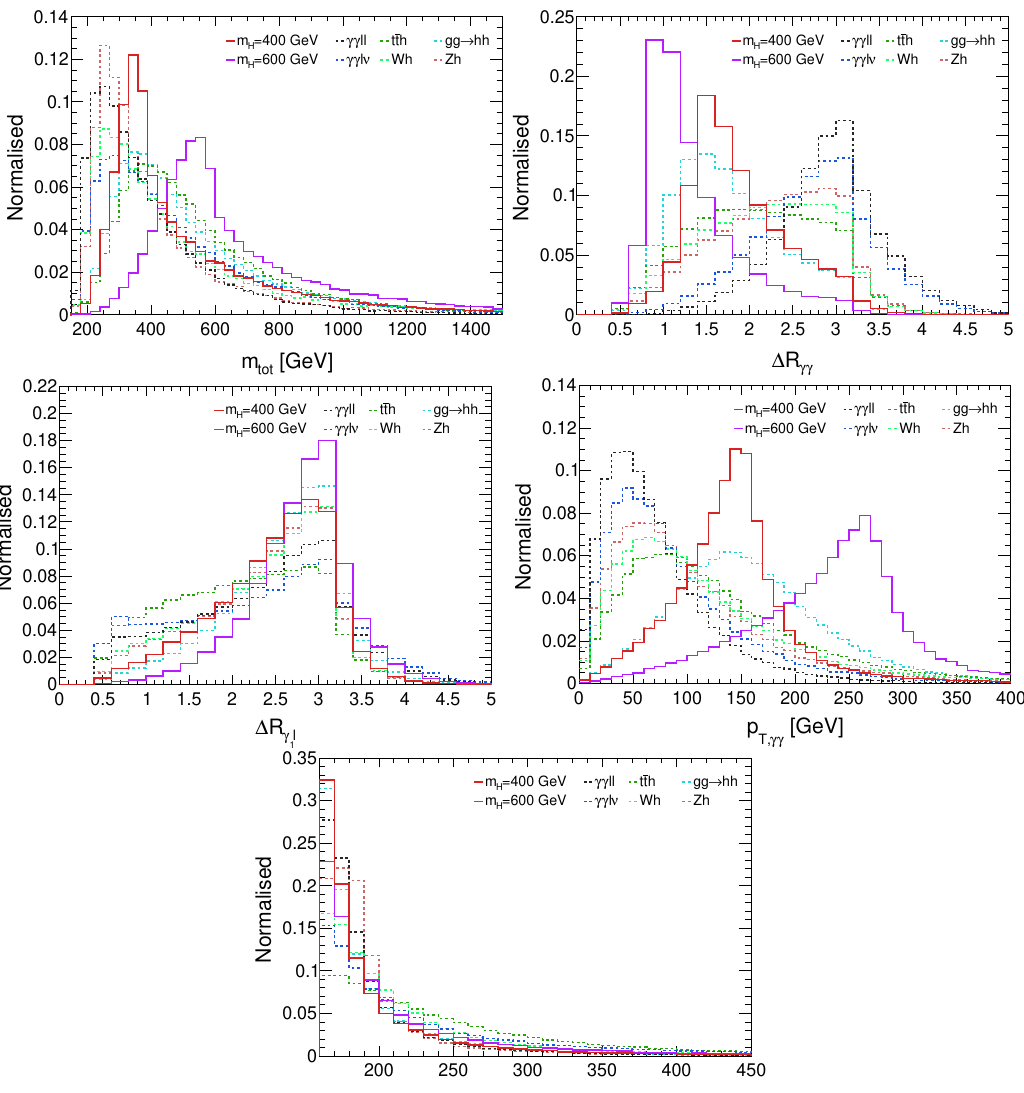
Figure 24 . The m tot , (cid:1) R (cid:13)(cid:13) , (cid:1) R (cid:13) , p T;(cid:13)(cid:13) and M T distributions for the 1 ‘ category for m H = 400 1 ‘ and 600 GeV with backgrounds. Here the heavy Higgs boson is searched for in the (cid:13)(cid:13)WW (cid:3) channel. The distributions are shown after imposing the basic trigger